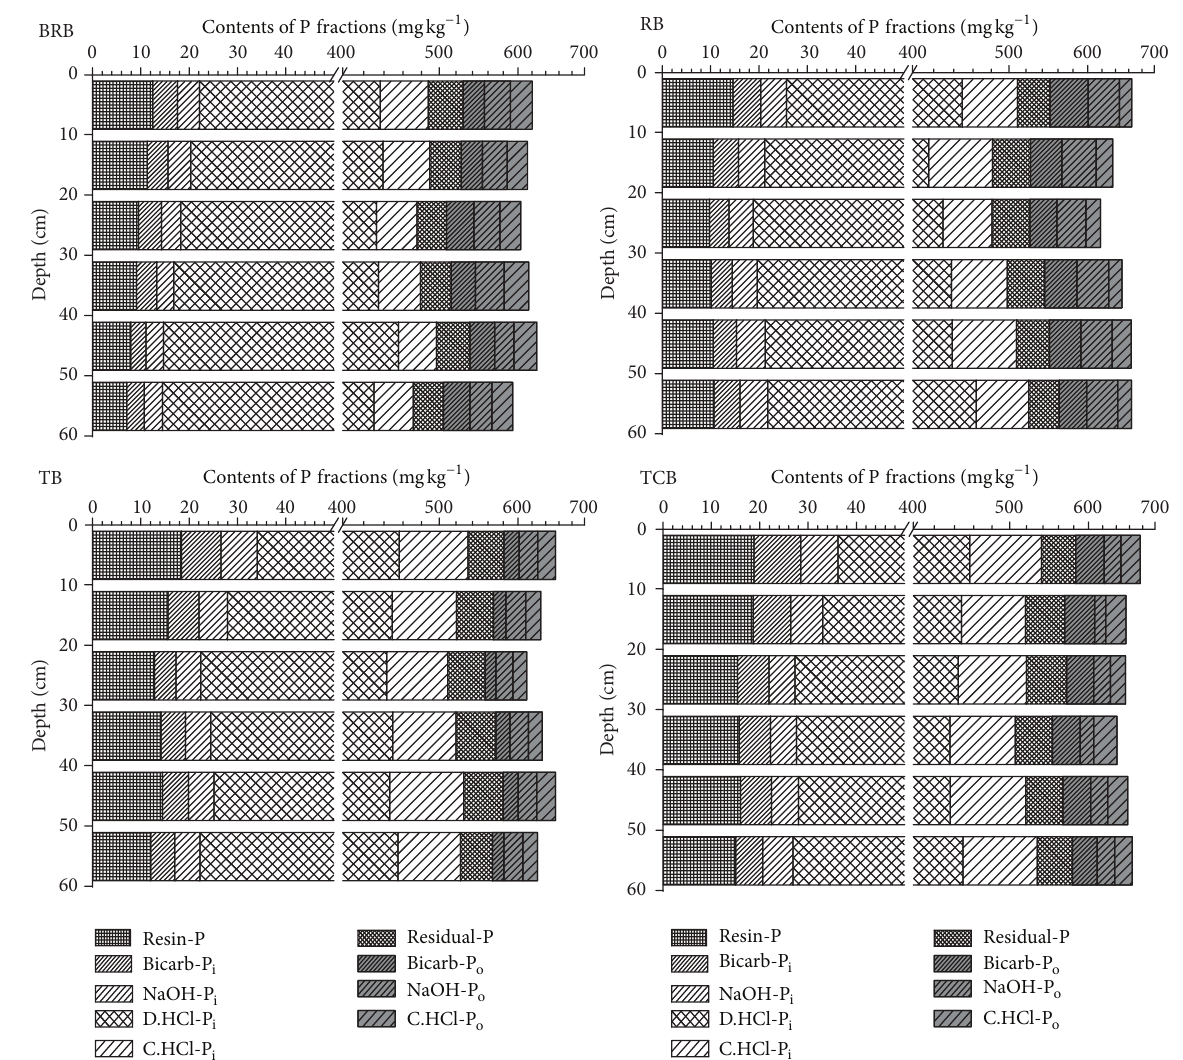
Figure 3: P fractions distribution in BRB, RB, TB, and TCB soil profiles (P forms including Resin-P, Bicarb-P i , NaOH-P i , D.HCl-P i , C.HCl-P i , Bicarb-P o , NaOH-P o , C.HCl-P o , and Residual-P).